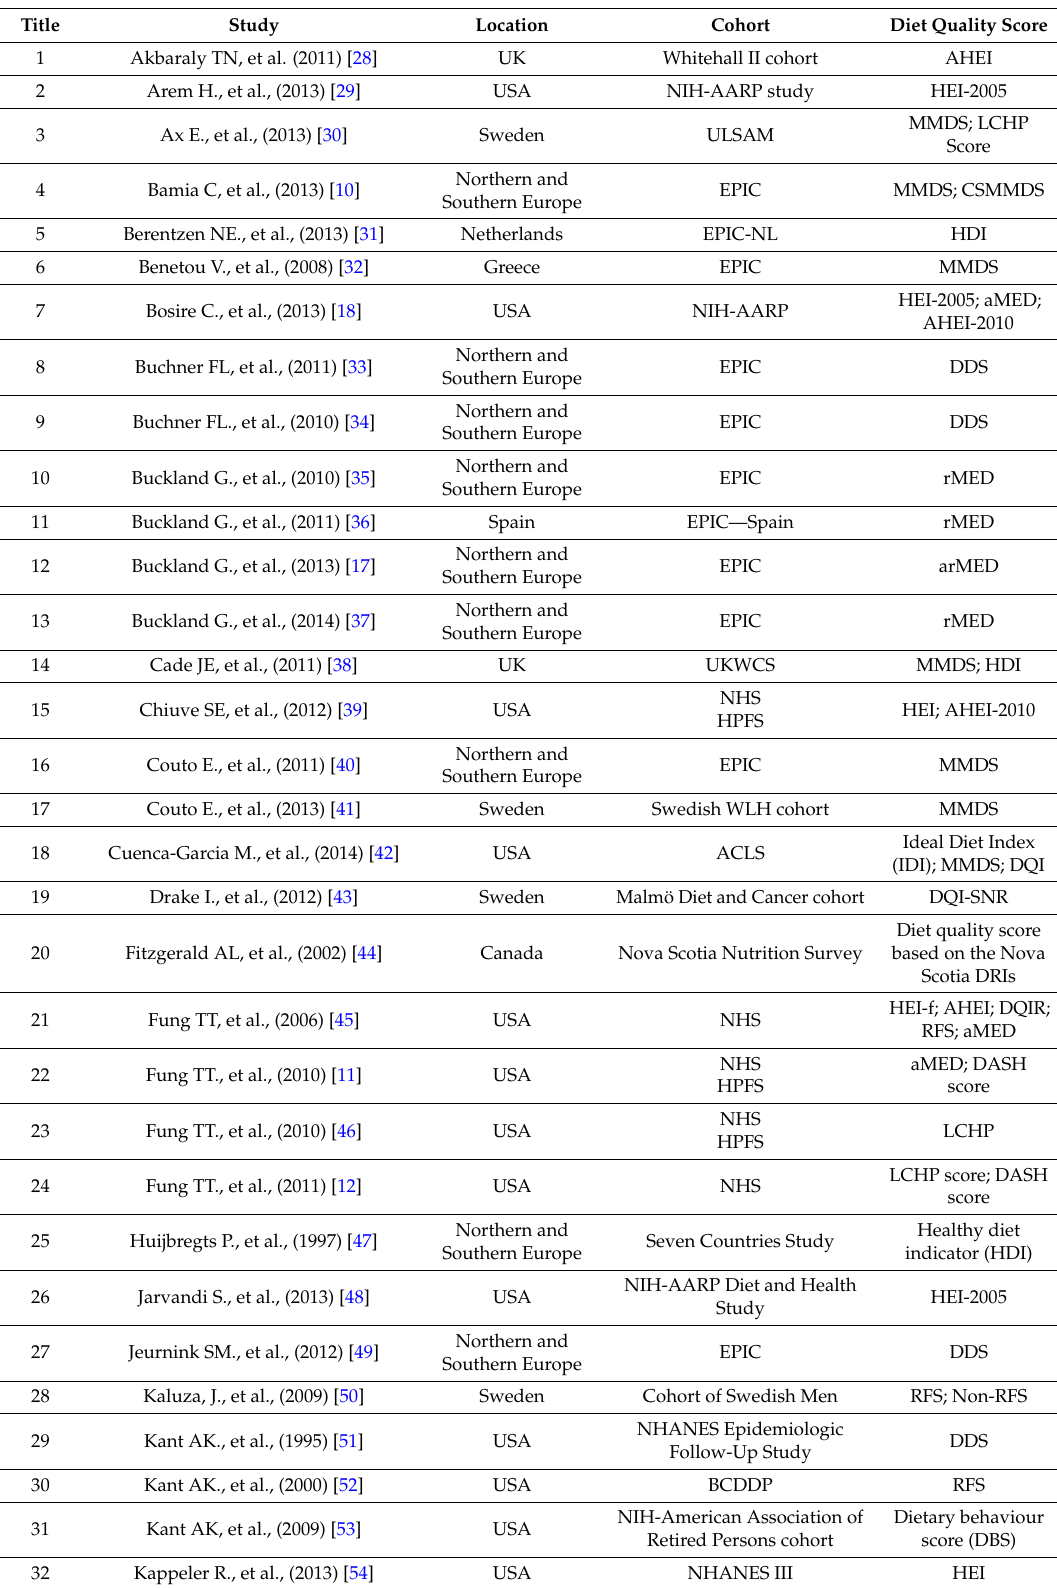
Table 2. Summary of included